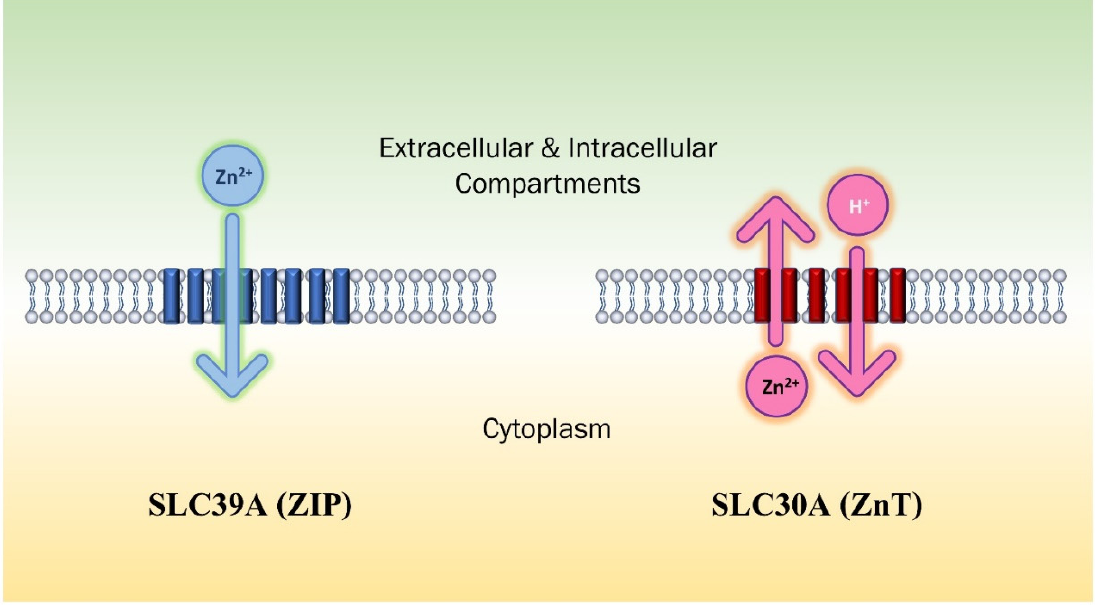
Figure 2. Zinc transporters SLC39A (ZIP) and SLC30A (ZnT) with Zn 2+ ion transportation direction. ZIP is predicted to have 8 transmembrane domains and ZnT is predicted to have 6.